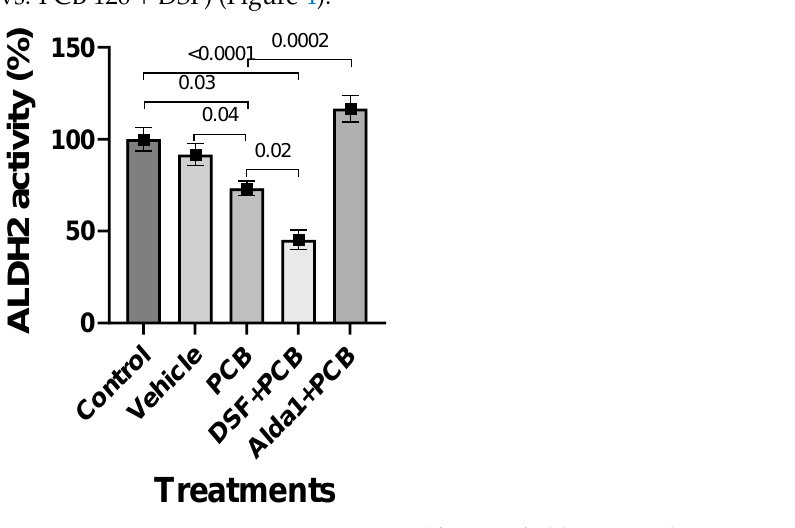
Figure 4. ALDH2 activity in PCB 126 and/or DSF/Alda 1-treated MCECs. Quantitative data of ALDH2 activity in MCECs after 24 h of PCB 126 treatment. n = 6 for each group. Each bar represents the mean ± SEM. DSF, disulfiram, PCB, polychlorinated biphenyl. 3.3. PCB 126 Increases the 4HNE Protein Adduct Levels, Whereas the Pharmacological Activation of ALDH2 Rescues the PCB-Mediated Effects in Cultured Mouse Coronary Endothelial Cells